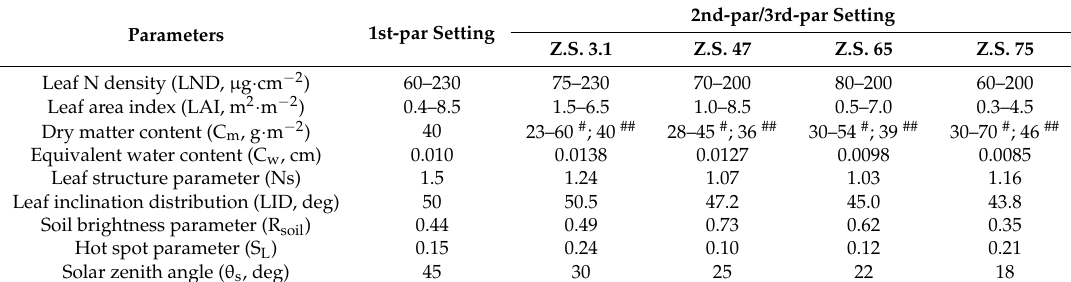
Table 3. Specific ranges and setting for input parameters in the N-PROSAIL